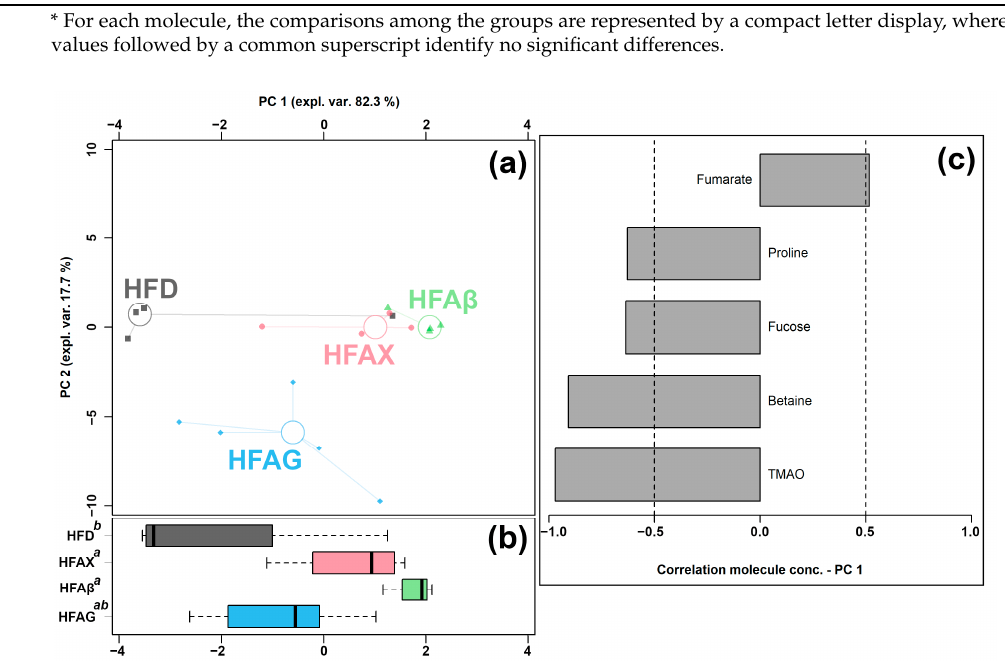
Table 4. Molecules with significant differences in cecum contents of HFD, HFAG, HFAXG, and HFXI groups.